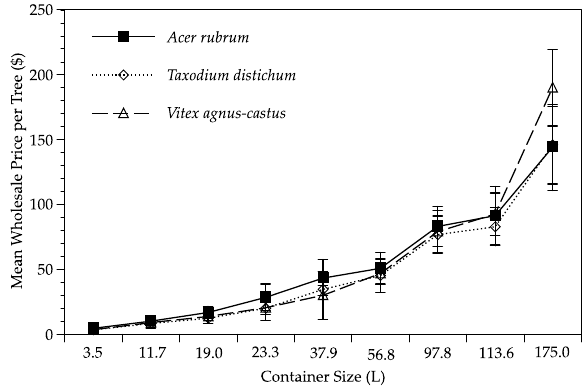
Figure 1. Mean ( ± standard error) wholesale price [US$] by container size for three tree species ( A. rubrum , T. distichum , and V. agnus-castus ) in 2013 where n ≥ 12. Similar trends were observed with the costs to transplant each container ‐ grown tree (Figure 2).